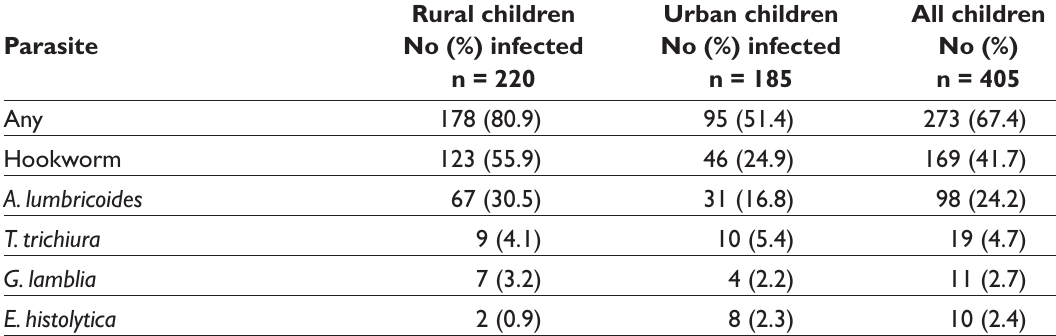
Table 1. Prevalence of Intestinal Parasites among Children in Rural and Urban Communities Rural children Urban children